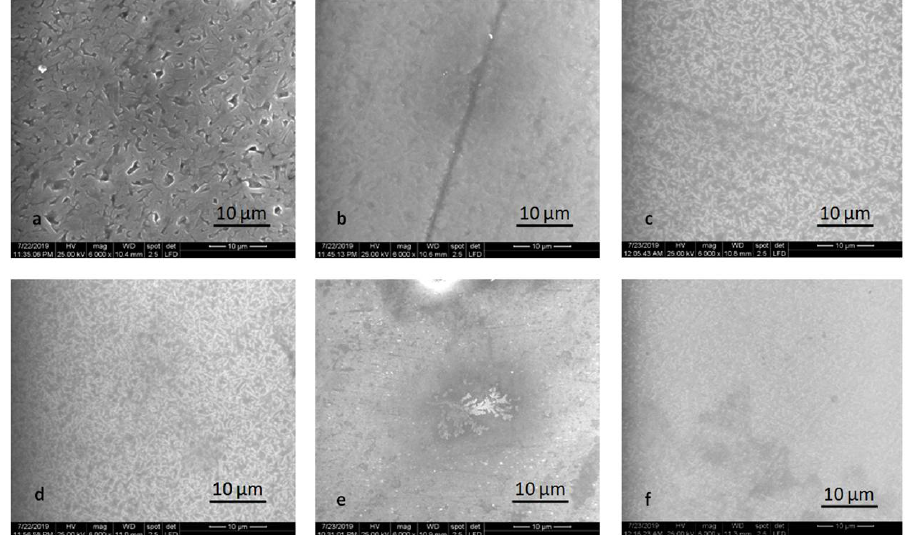
Figure 5. Scanning electron microscopy (SEM) images of the polished samples: ( a ) LDS-P-P-HT, ( b ) LDS-P-P-MT, ( c ) LDS-M-P-MT, ( d ) ZLS-P-P-HT, ( e ) ZLS-P-P-MT, and ( f ) ZLS-M-P-MT.